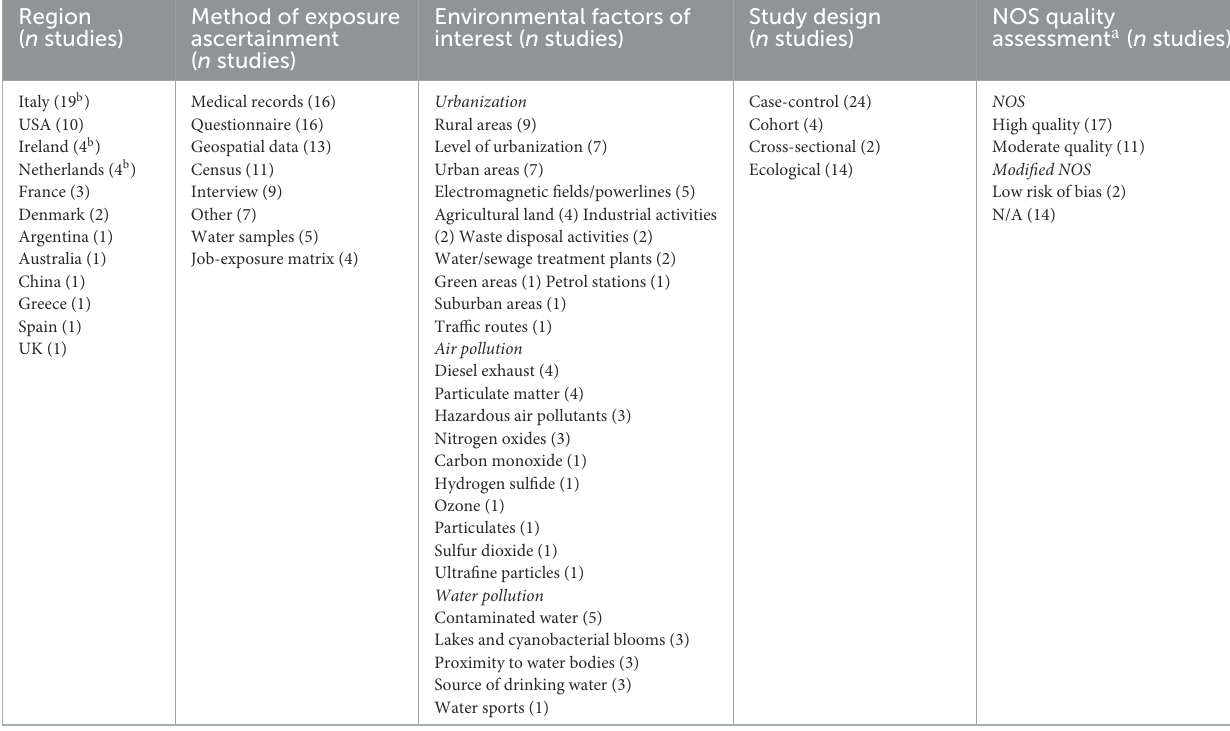
TABLE 1 Summary of study characteristics (region, method of exposure ascertainment, environmental factors of interest, study design, and Newcastle-Ottawa Scale quality assessment) for the 44 unique studies included from the combined search